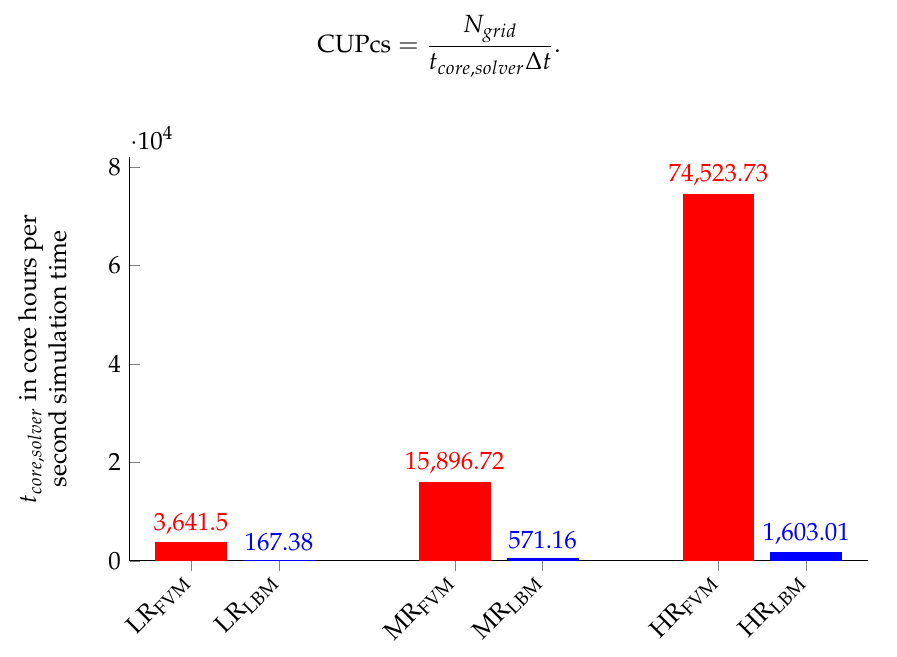
Figure 14. Solver runtime t core , solver comparison between OpenFOAM and OpenLB for the three grid configurations: LR, MR and HR.